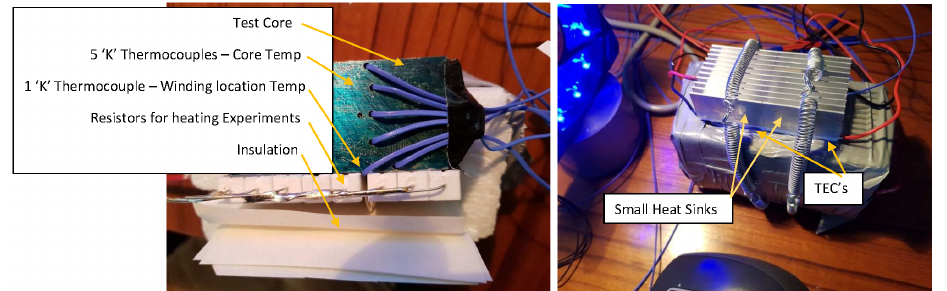
Figure 10. Sample arrangement with K type thermocouples and thermoelectric coolers (TECs) with heat